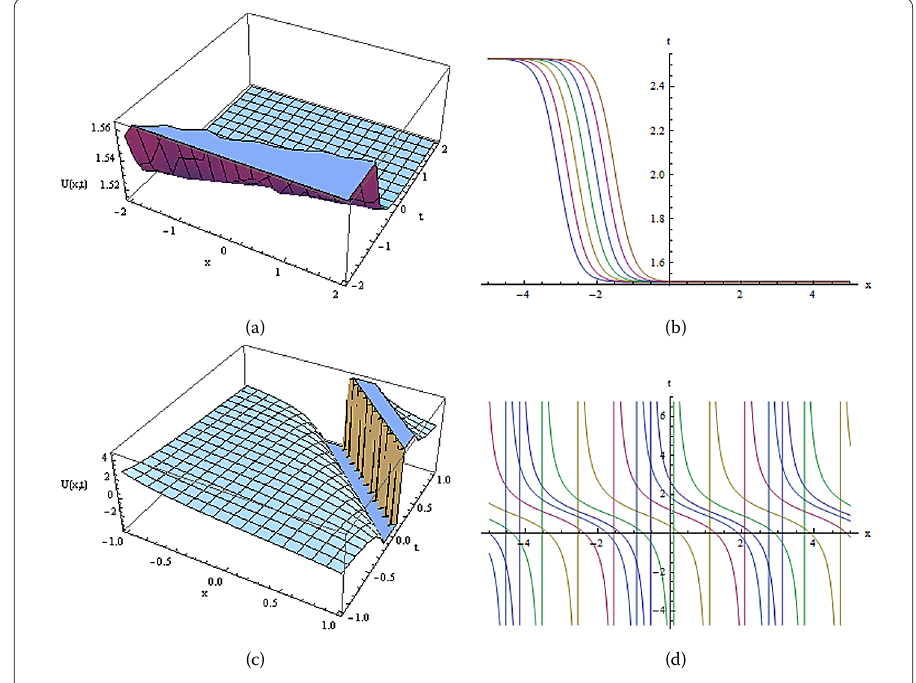
Figure 1 The 3D surfaces of Eq. (9) for solution (15) at ( a ) and solution (16) at ( b ) are plotted by assigning different values to the parameters under the constrain conditions